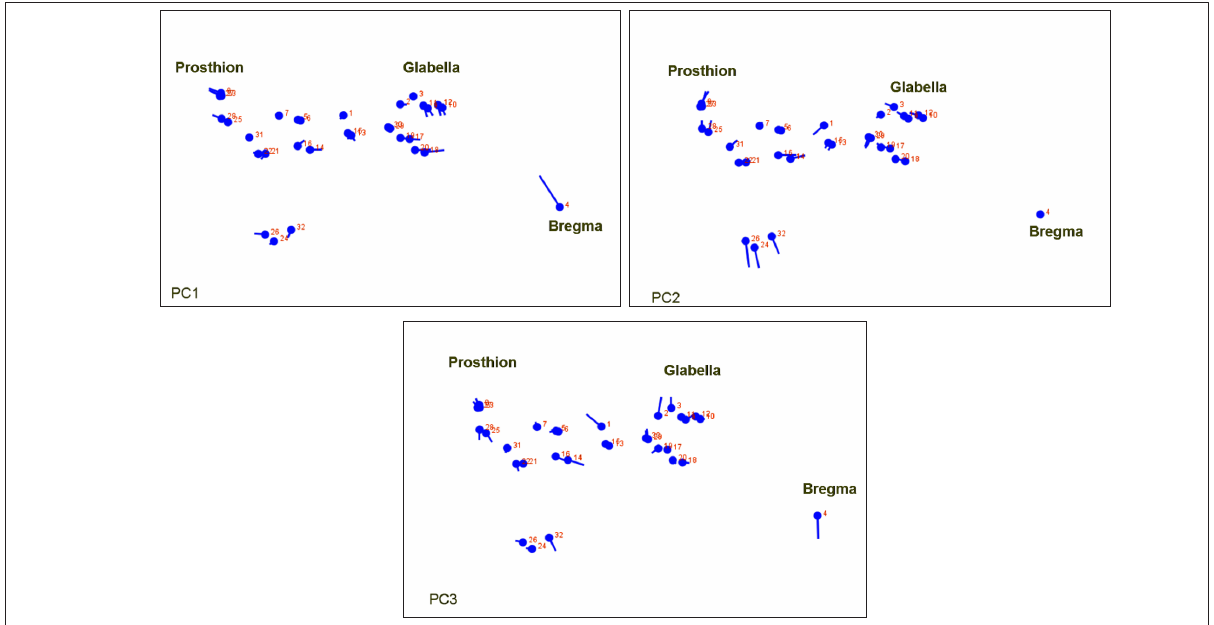
Figure 6: Visualisations of shape change for principal component axes 1–3. Axes correspond to Figure 5. http://www.sajs.co.za